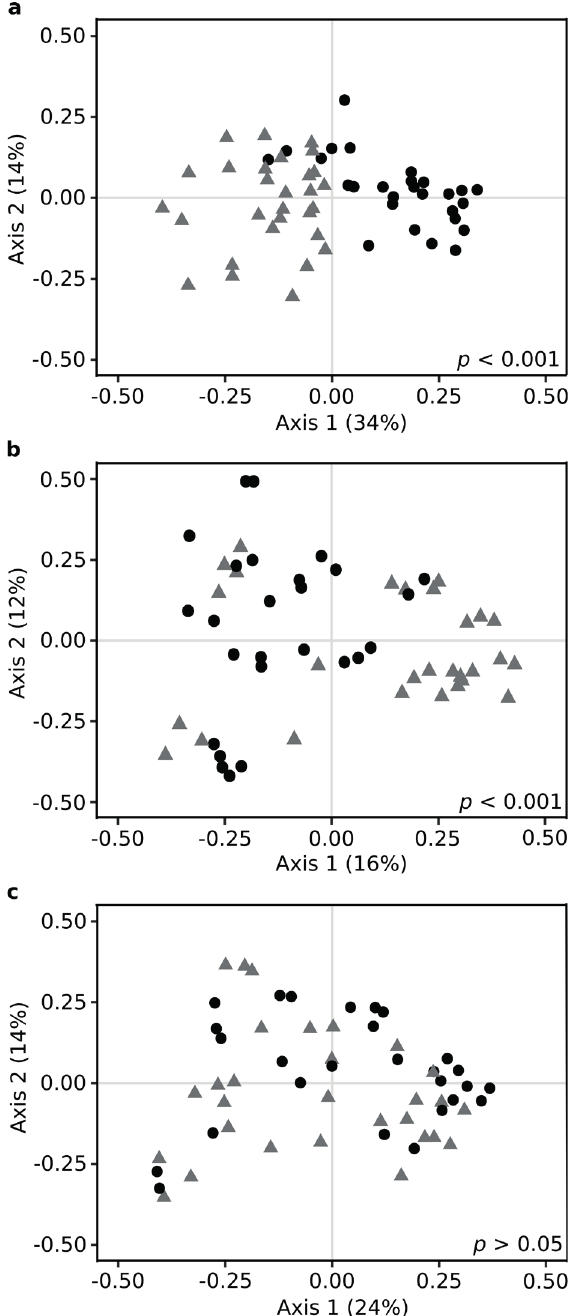
Figure 4 - PCoA unconstrained ordination using the biological data of the dinoflagellate assemblage ( a ), tintinnid ciliates assemblage ( b ), and polycystine radiolarians assemblage ( c ). The black circles represent samples collected in the surface mixed layer (SML) and the gray triangles represent samples collected in the subsurface layer (SSL). The p value of a PERMANOVA comparing each assemblage in both layers is also